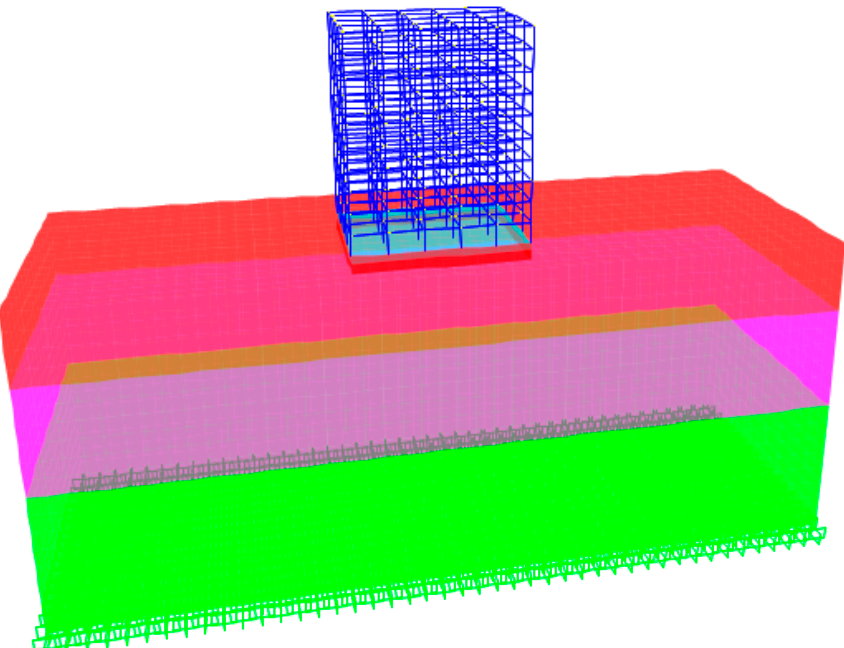
Figure 3. 3D view of 10s- soil-structure-interaction (SSI) model.